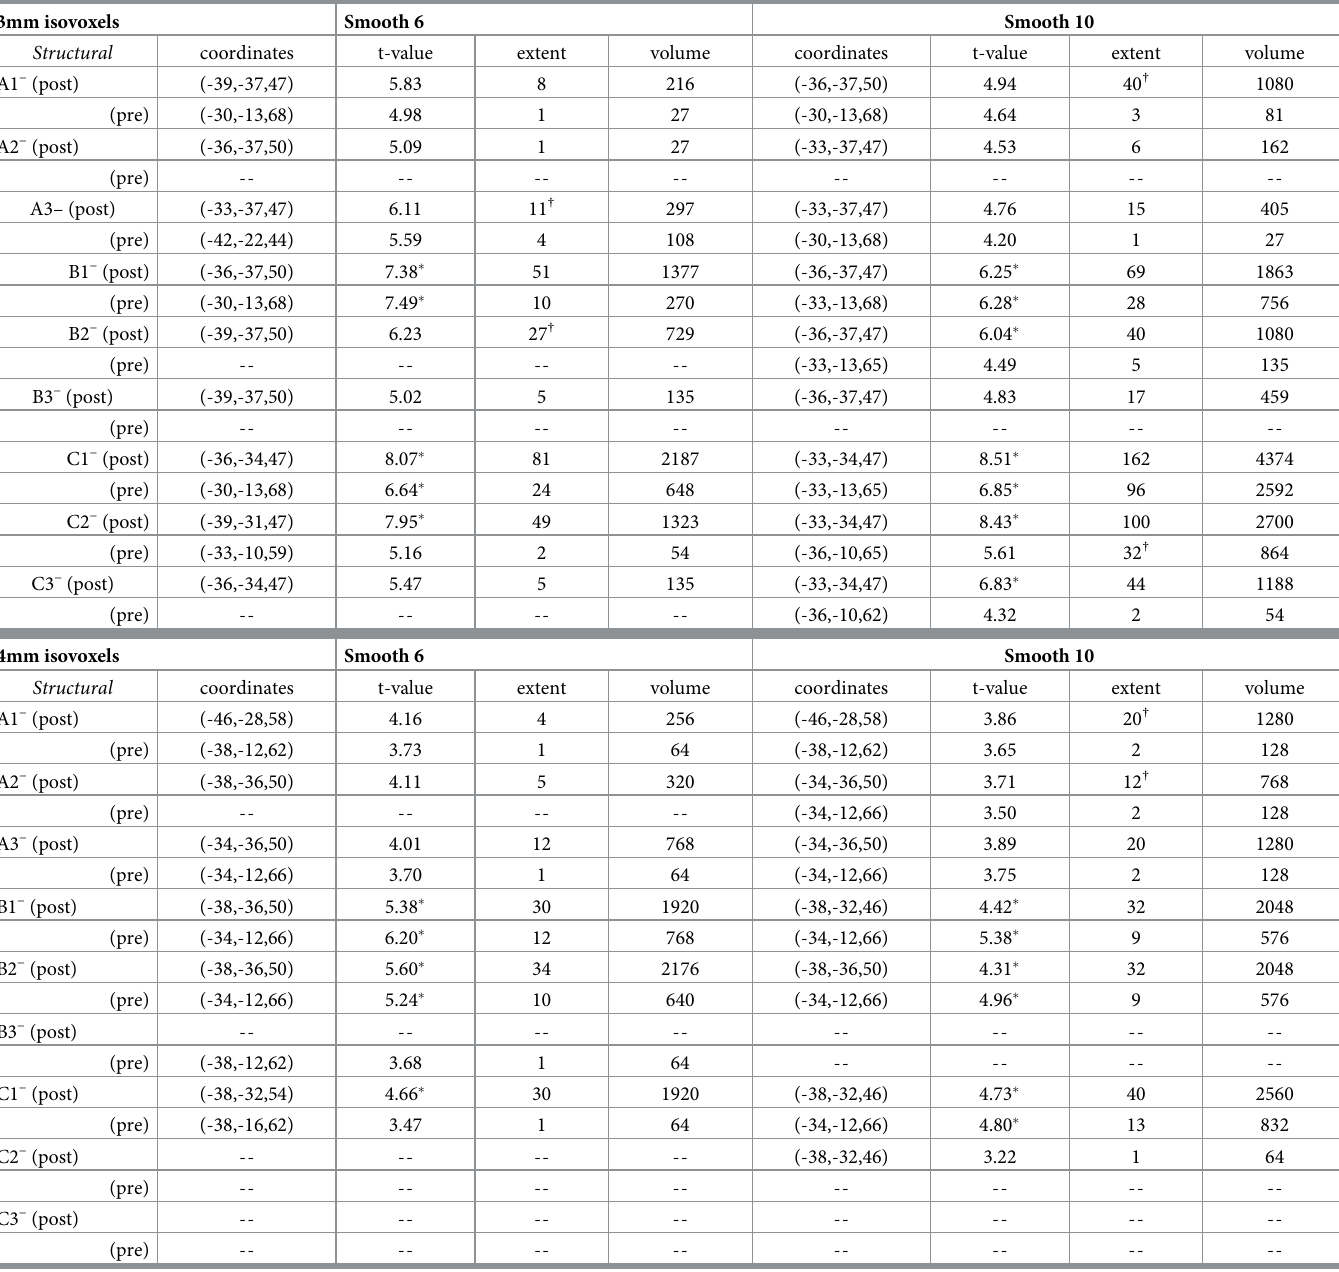
Table 5. Smoothing kernel effects on hippocampal connectivity from structural seeds during sequence